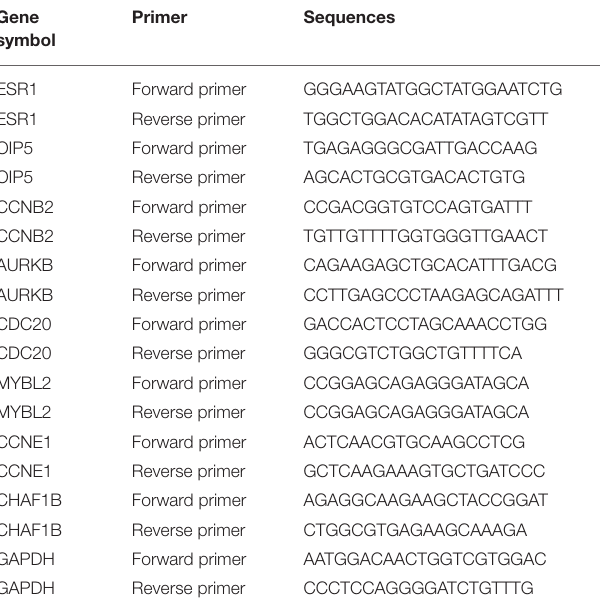
TABLE 1 | The sequences of primers used in this